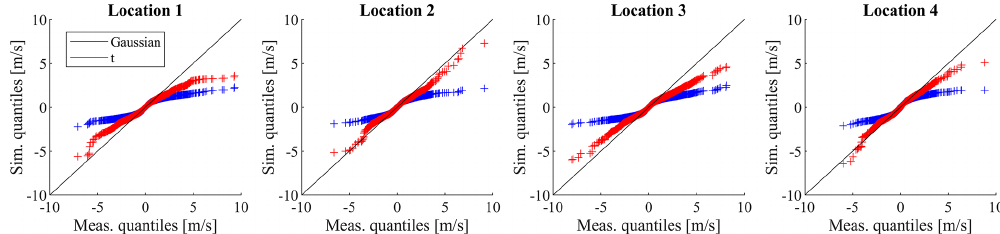
Figure 7. The qq-plot of simulated vs. measured wind speed fluctuation in 10min.